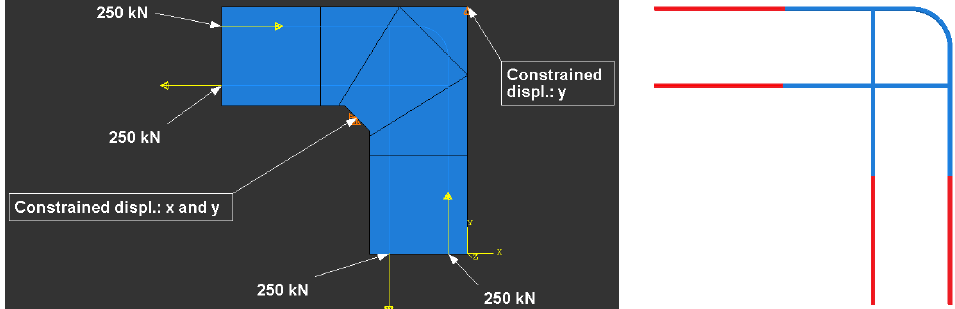
Figure 18. Meshing of concrete and reinforcing steel (detail NO. 7) and analyzed nodal displace- ment.